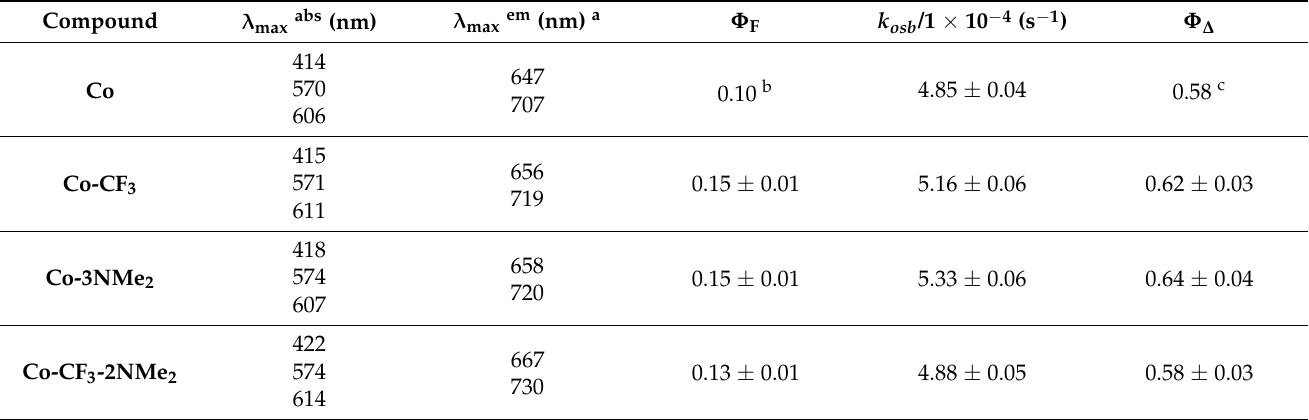
Table 1. Spectroscopic and photodynamic properties of corrole derivatives in